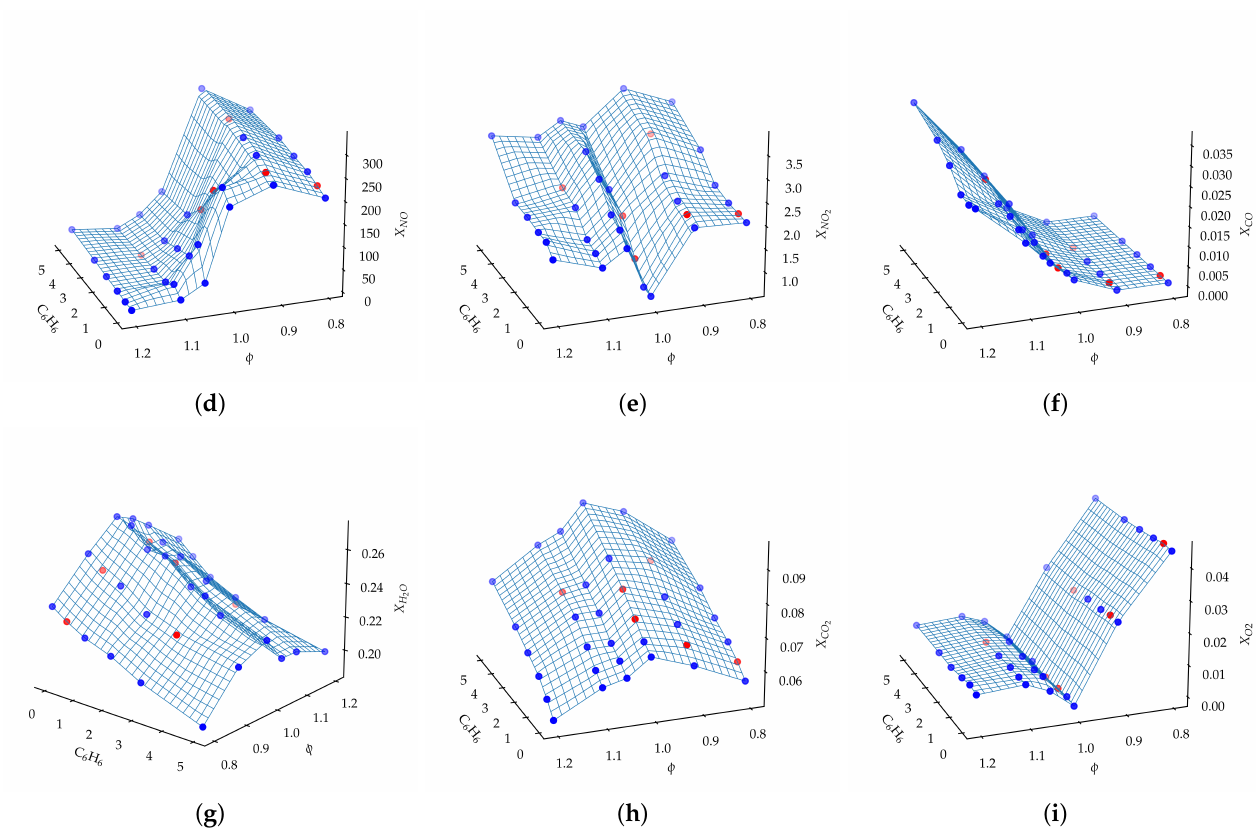
Figure A1. Maximum temperature ( a ); OH ∗ normalized sum ( b ); CH ∗ normalized sum ( c ); emissions of NO ( d ); NO 2 ( e ); CO ( f ); H 2 O ( g ); CO 2 ( h ) and O 2 ( i ), as a function of the input parameters. The OH ∗ and CH ∗ values have been obtained by summing all the counts for each condition, and they have been normalized by the maximum value. The blue dots indicate the samples used for training while the red dots represent the samples used for